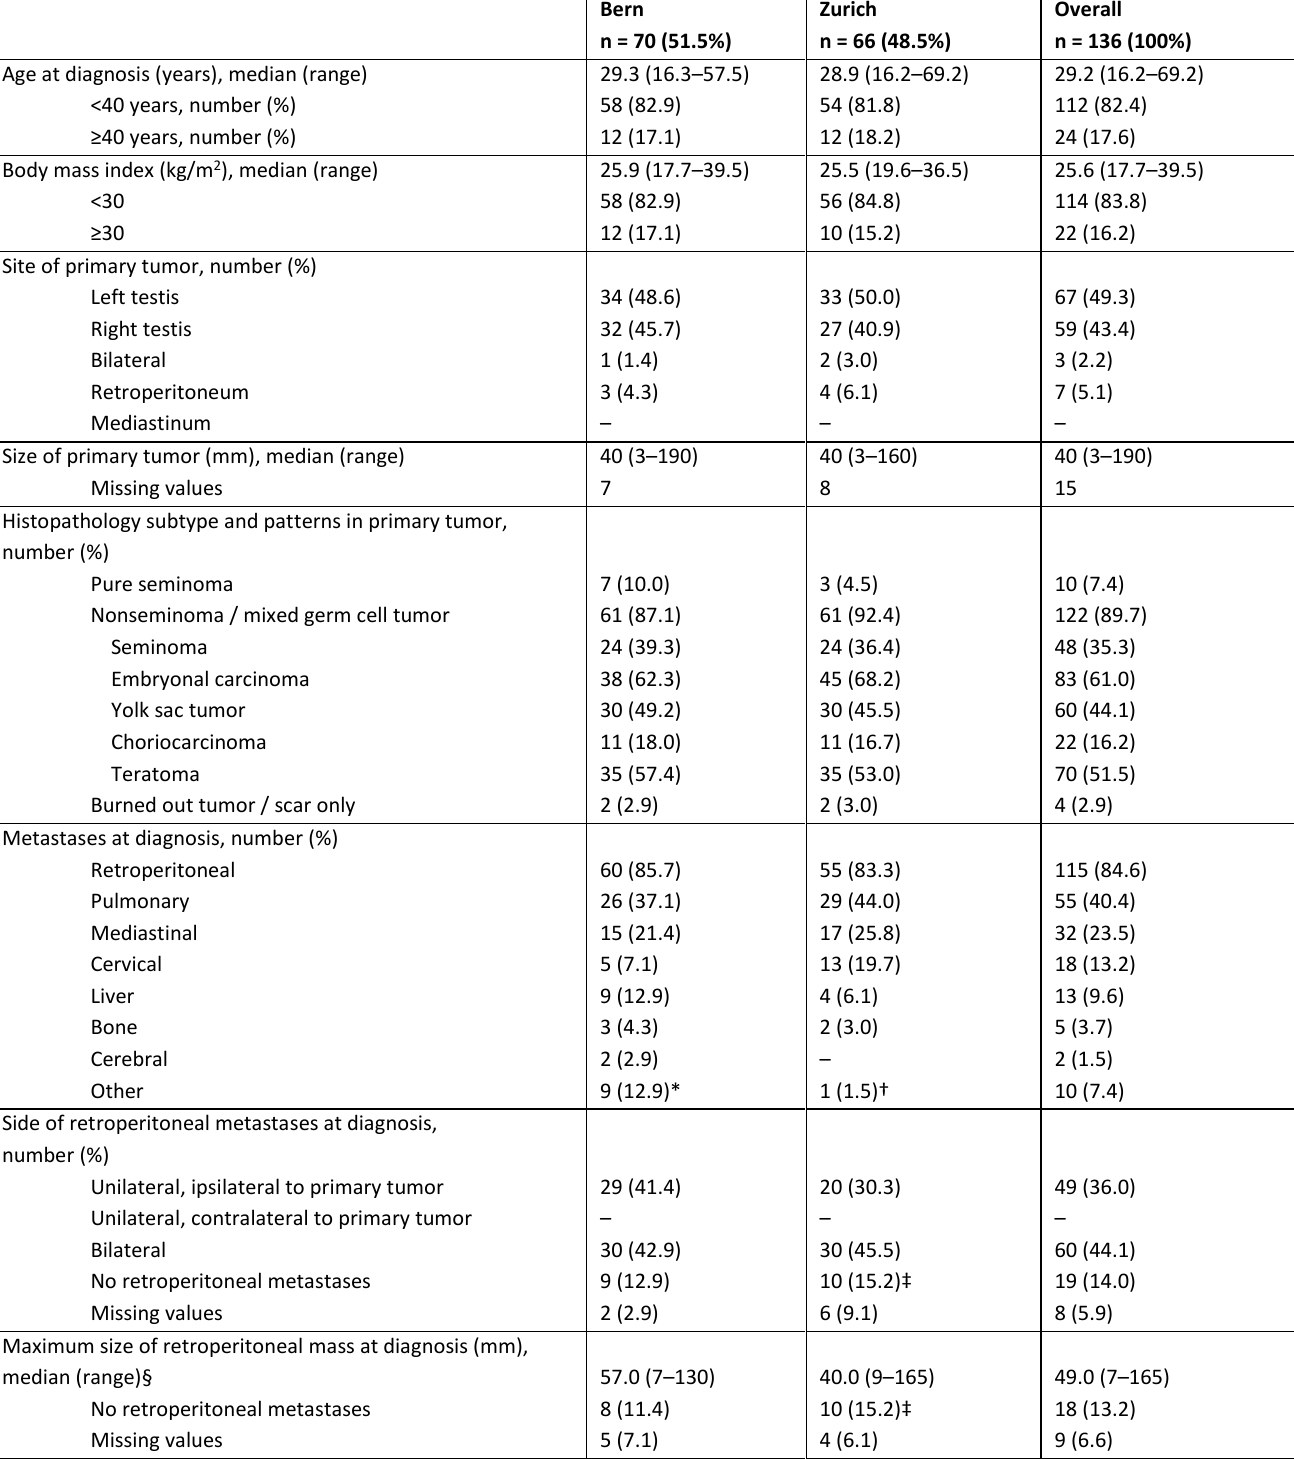
Supplementary table 1. Patients’ baseline